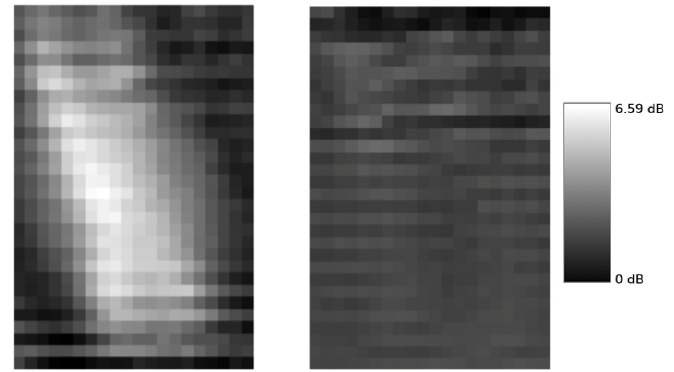
Figure 11. Test results with a green leaf ( left ) and dry leaf ( right )